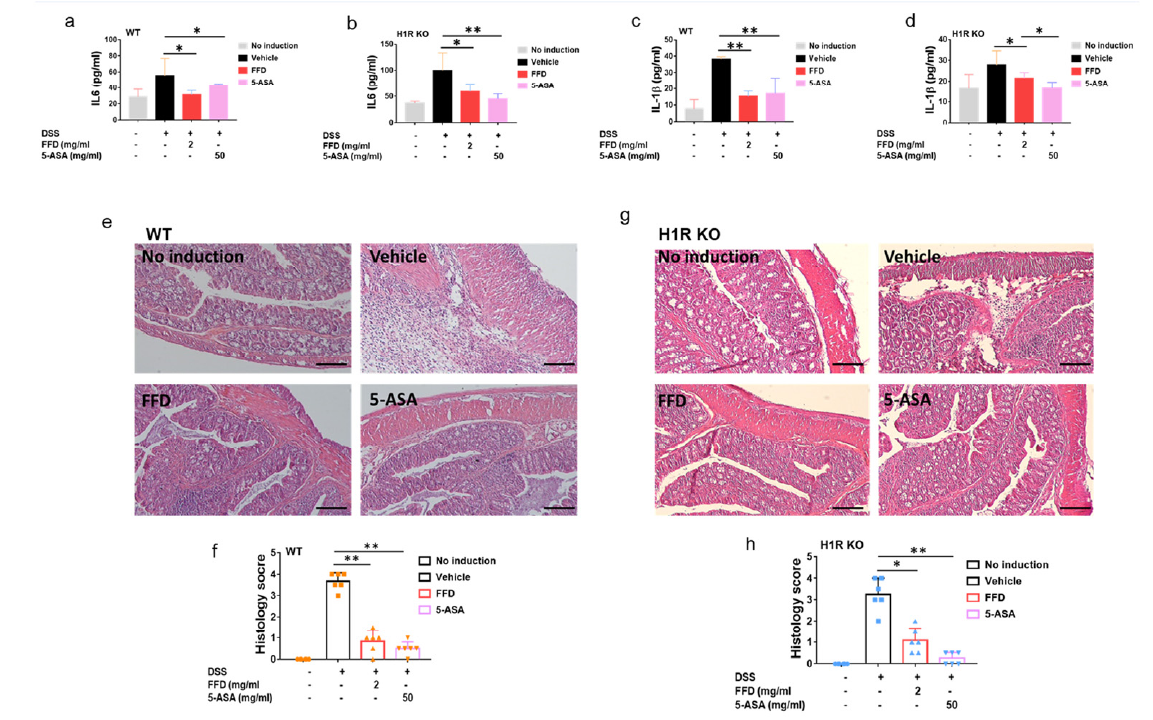
Figure 6. Inflammatory response of FFD-treated or controls in DSS-induced WT and H1R KO mice. ( a – d ) Serum levels of IL-1 β and IL-6. ( a ) Serum level of IL-6 in ctrl, or 5-ASA or FFD-treated WT group. ( b ) Serum level of IL-6 in ctrl, or 5-ASA or FFD-treated H1R KO group. ( c ) Serum level of IL-1 β in ctrl, or 5-ASA or FFD-treated WT group. ( d ) Serum level of IL-1 β in ctrl, or 5-ASA or FFD-treated H1R KO group. ( e , f ) H&E staining and its quantitative analysis in colon tissue sections in ctrl or 5-ASA, or FFD-treated WT group. ( g , h ) H&E staining and its quantitative analysis in colon tissue sections in ctrl or 5-ASA, or FFD-treated H1R KO group. Statistical analysis was done to compare the treatment groups and vehicle groups. n = 6 per group. Data are mean ± SE; * p < 0.05, ** p < 0.01. (Scale bar, 100 µ